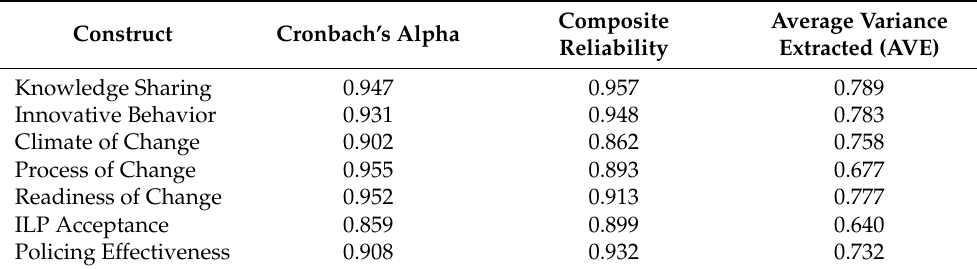
Table 1. Measurement Reliability and Validity.